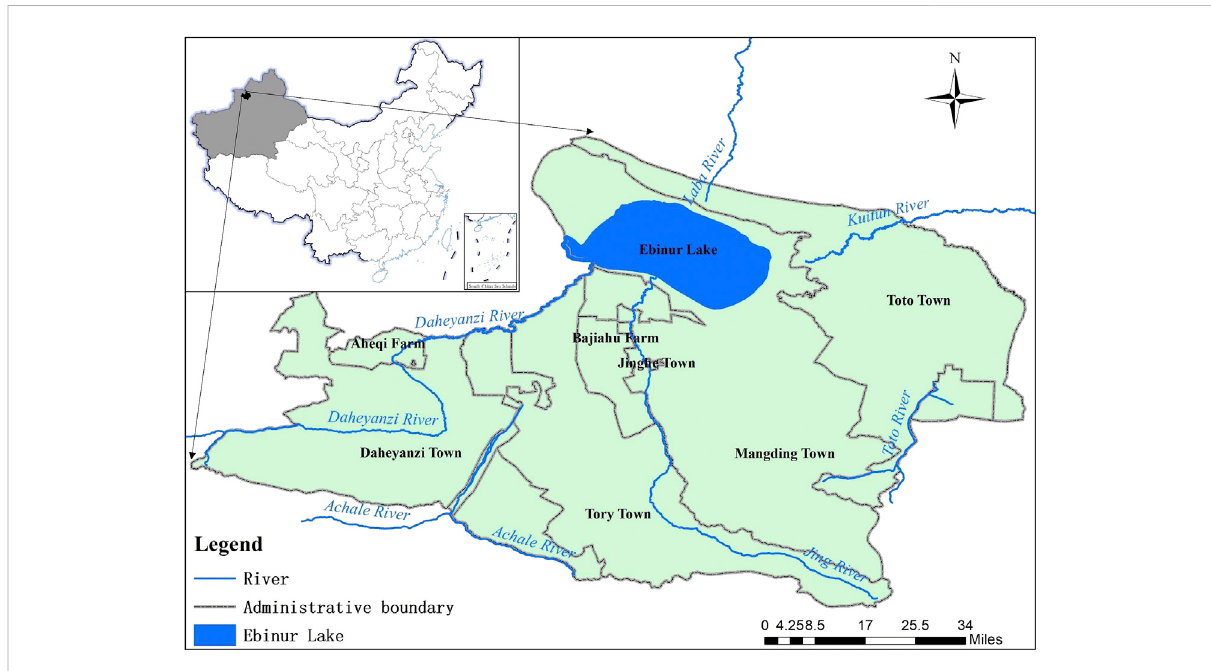
FIGURE 2 Location of Jiange County in the northwest of Xinjiang, China.